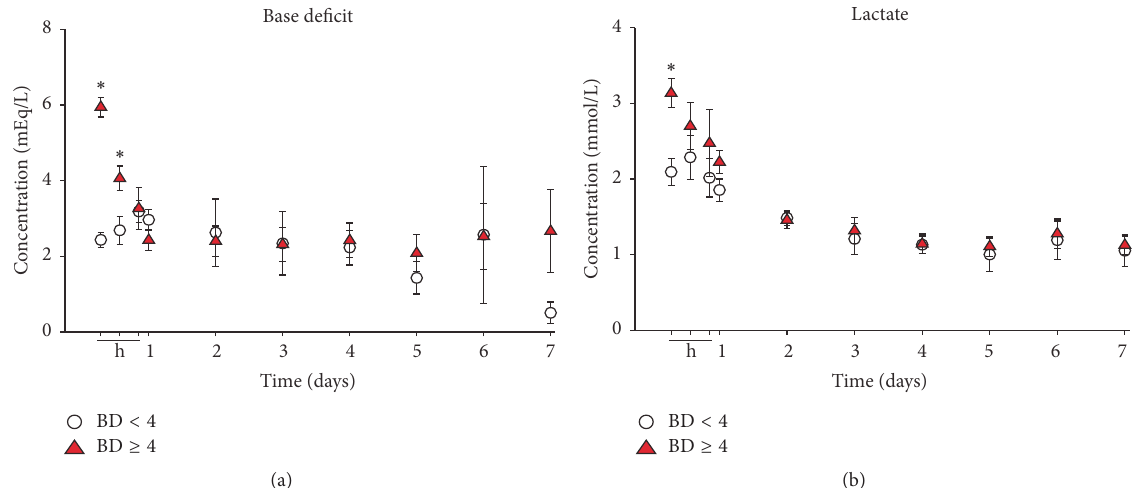
Figure 1: (a) Arterial base deficit (BD) from time of admission up to 7 days after injury between BD ≥ 4 and BD < 4 subgroups. The BD ≥ 4 group had statistically significantly elevated BD levels at 8h and 16 h after injury when compared to the BD < 4 group. BD in both subgroups approach similar values at 24 h after injury. ∗ 𝑃 < 0.05 by two-way ANOVA. (b) Plasma lactate levels from time of admission up to 7 days after injury between BD ≥ 4 and BD < 4 subgroups. The BD ≥ 4 group had statistically significantly elevated lactate levels at 8 h after injury when compared to the BD < 4 group. BD in both subgroups approaches normal values at 24 h after injury. ∗ 𝑃 < 0.05 by two-way